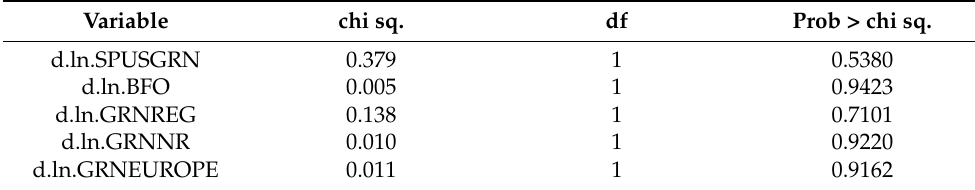
Table 6. LM test for the presence of the ARCH effect. Variable chi sq. df Prob > chi